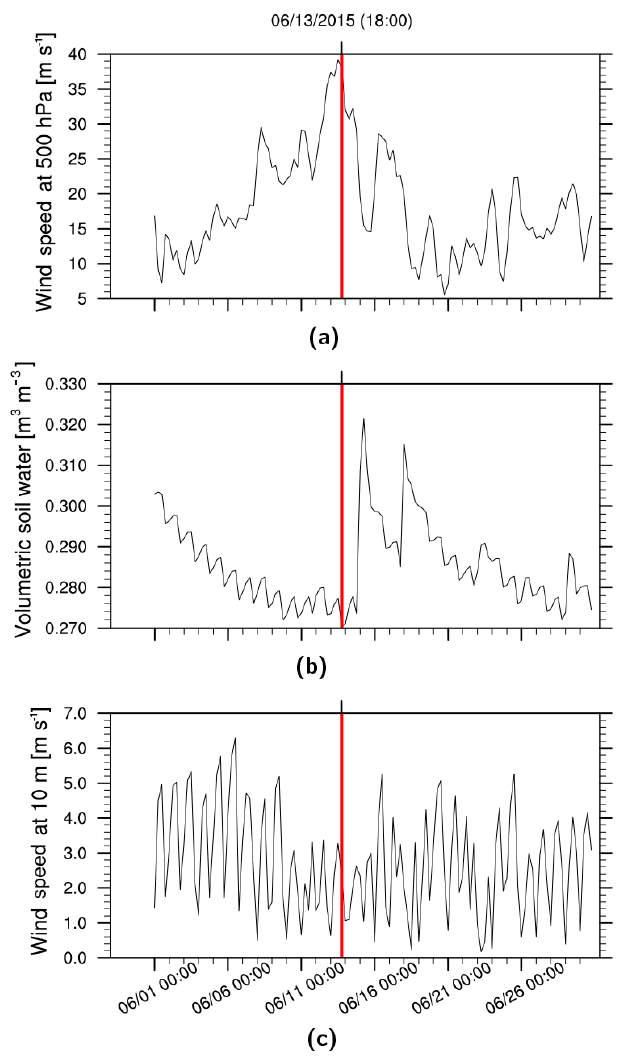
Figure 6. Time series at Fiambalá coordinates during June for wind speed at 500hPa (a) , volumetric soil water (b) , and wind speed at 10m (c) . The conditions on 13 June at 18:00UTC (red line) al- lowed dust to be raised in suspension in the atmosphere. Dataset from ERA-Interim